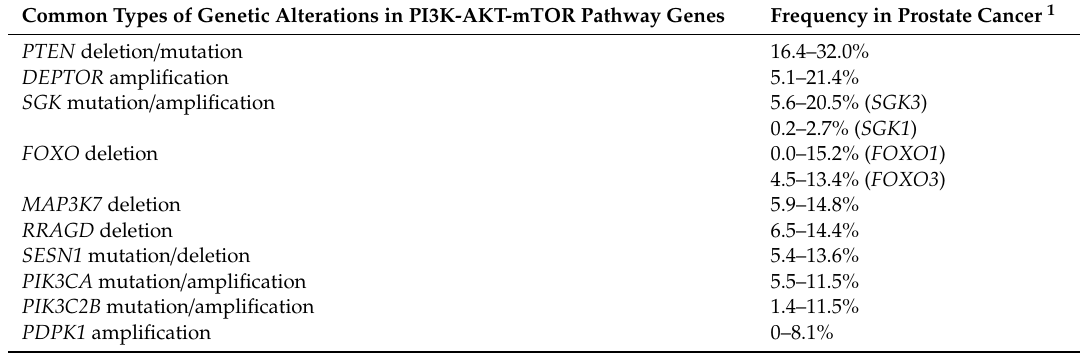
Table 1. Frequency of common genetic alterations in PI3K-AKT-mTOR pathway genes in prostate cancer. Common Types of Genetic Alterations in PI3K-AKT-mTOR Pathway